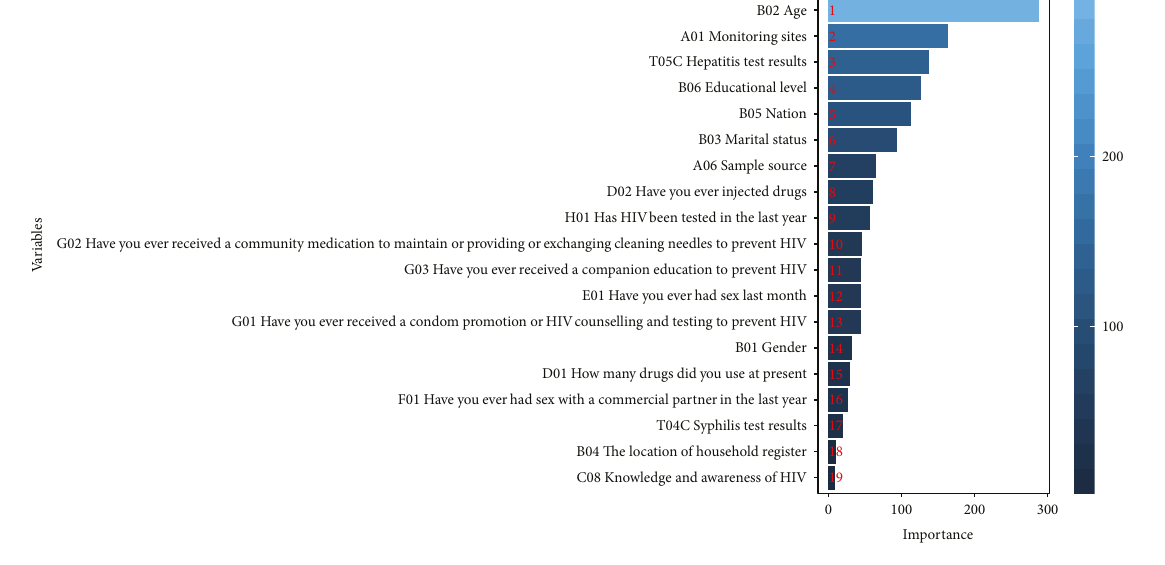
Figure 3: The importance of variables of IDU dataset. Table 6: Selection attributes used in models of MSM